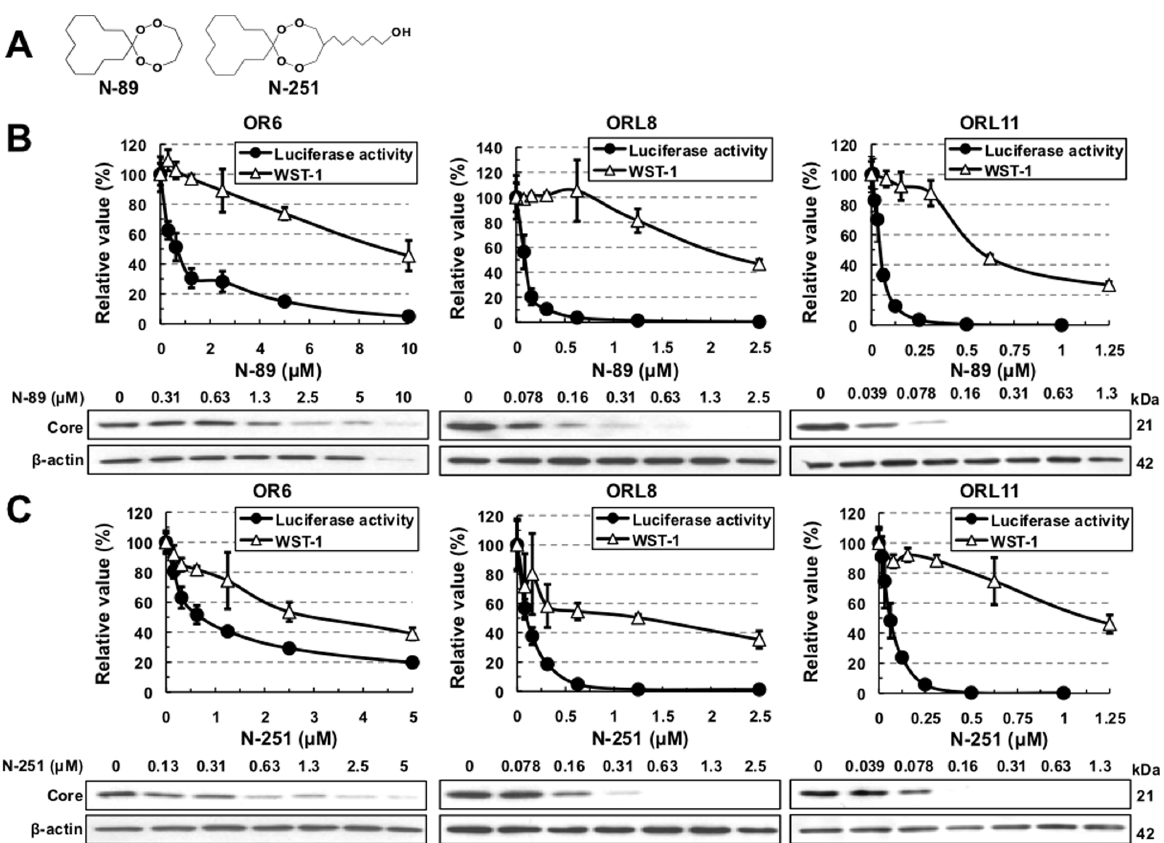
Figure 1. Anti-HCV activities of N-89 and N-251 detected in the OR6, ORL8, and ORL11 assays. (A) Structures of N-89 and N-251. (B) Effects of N-89 on genome-length HCV-RNA replication. OR6, ORL8, and ORL11 cells were treated with N-89 for 72 hrs, followed by RL assay (black circles in the upper panel) and WST-1 assay (open triangles in the upper panel). The relative value (%) calculated at each point, when the level in non- treated cells was assigned as 100%, is presented here. Data are expressed as the means 6 standard deviation of triplicate assays. Western blot analysis of the treated cells for the HCV Core was also performed (lower panel). b -actin was used as a control for the amount of protein loaded per lane. (C) Effects of N-251 on genome-length HCV-RNA replication. The RL assay, WST-1 assay, and Western blot analysis were performed as described in (B).